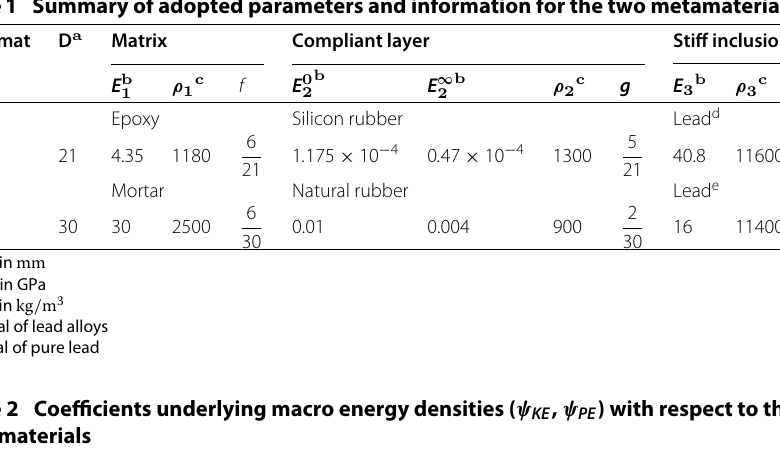
Table 2 Coefficients underlying macro energy densities ( ψ KE , ψ PE ) with respect to the two metamaterials Meta-mat C ( 1 ) C ( 2 ) C ( 3 ) 272.1